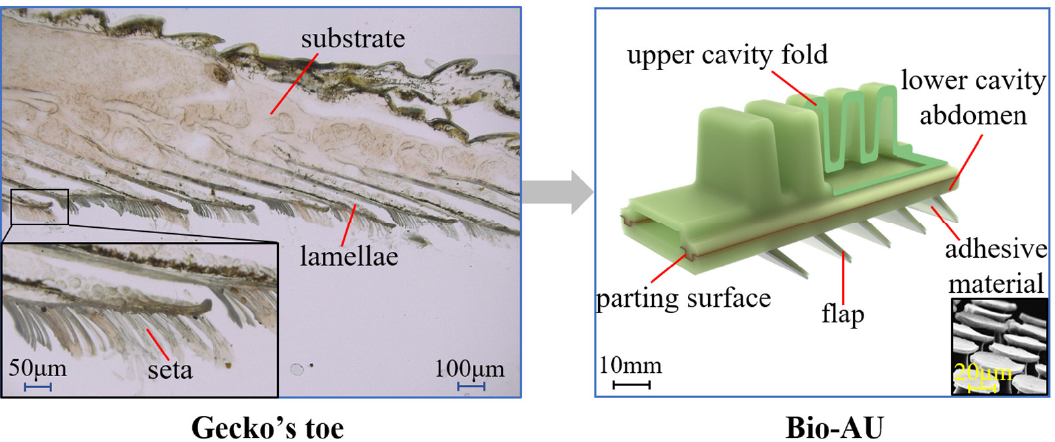
Figure 1. Design inspiration and structure of bio-inspired adhesive unit (Bio-AU).